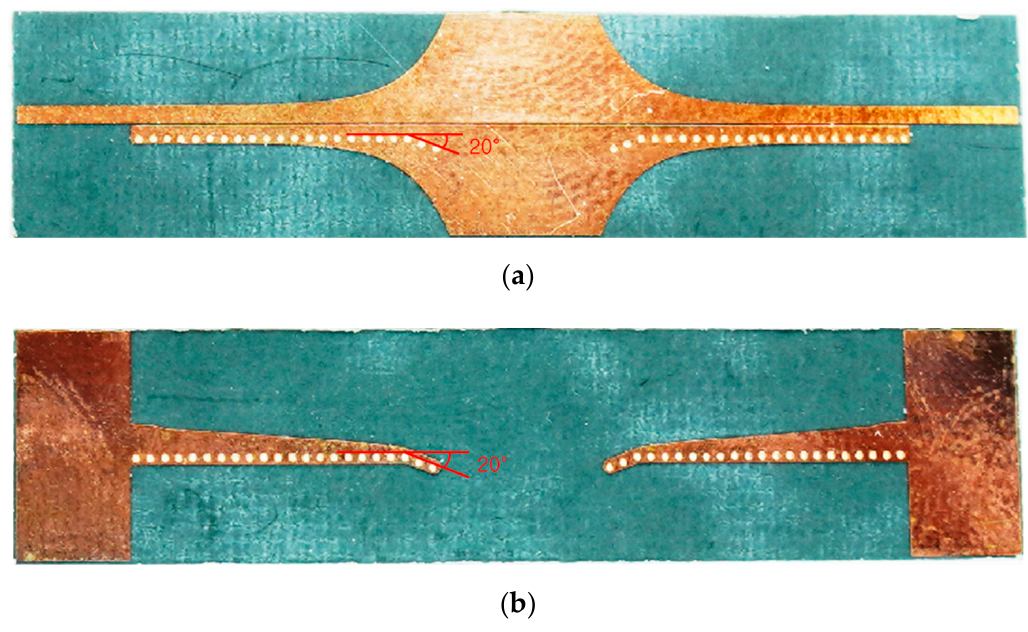
Figure 9. Fabricated microstrip-to-slotline transition: ( a ) top view; ( b ) bottom view. Table 3. Dimensions of the proposed transition (unit: mil).